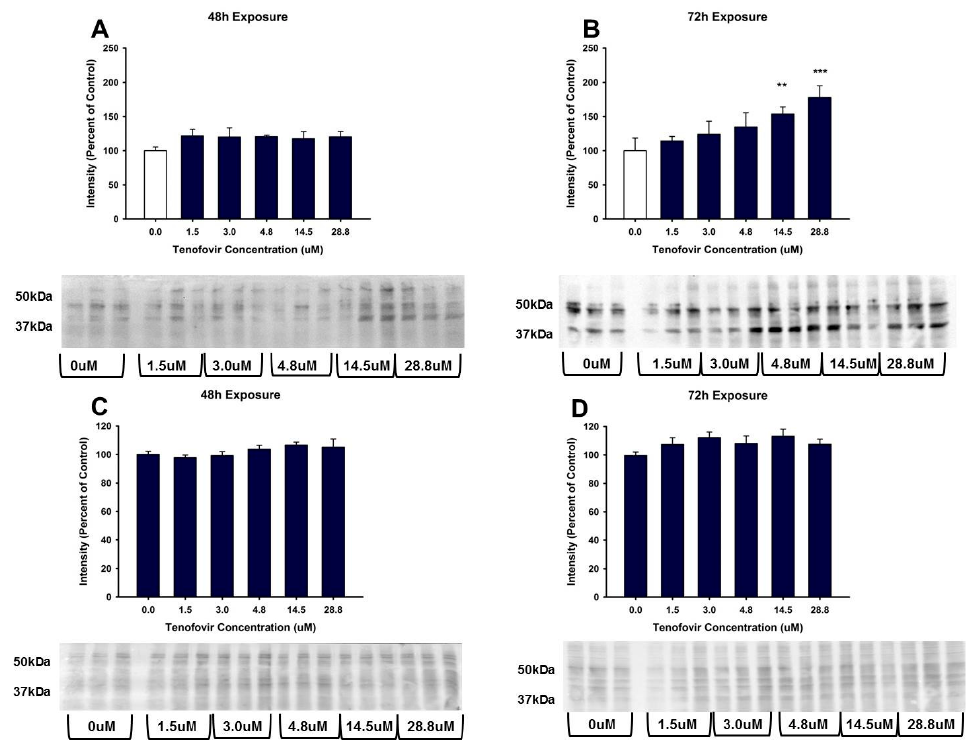
Figure 4. Tenofovir treatment for 72 h increased protein carbonylation in HK-2 cells. Protein carbonylation was measured in HK-2 cell lysate following 48 ( A ) and 72 h ( B ) exposure to TFV. Representative gel and cumulative densitometry included in each panel. Representative blot with MemCode Reversible staining for equal 25 µ g protein loading and cumulative protein densitometry depicted for 48 ( C ) and 72 h ( D ) exposure. Asterisks (** p < 0.01, *** p < 0.001) indicate statistical difference from the vehicle control group. Each bar represents Mean ± SEM for three independent experiments run with three biological replicates.